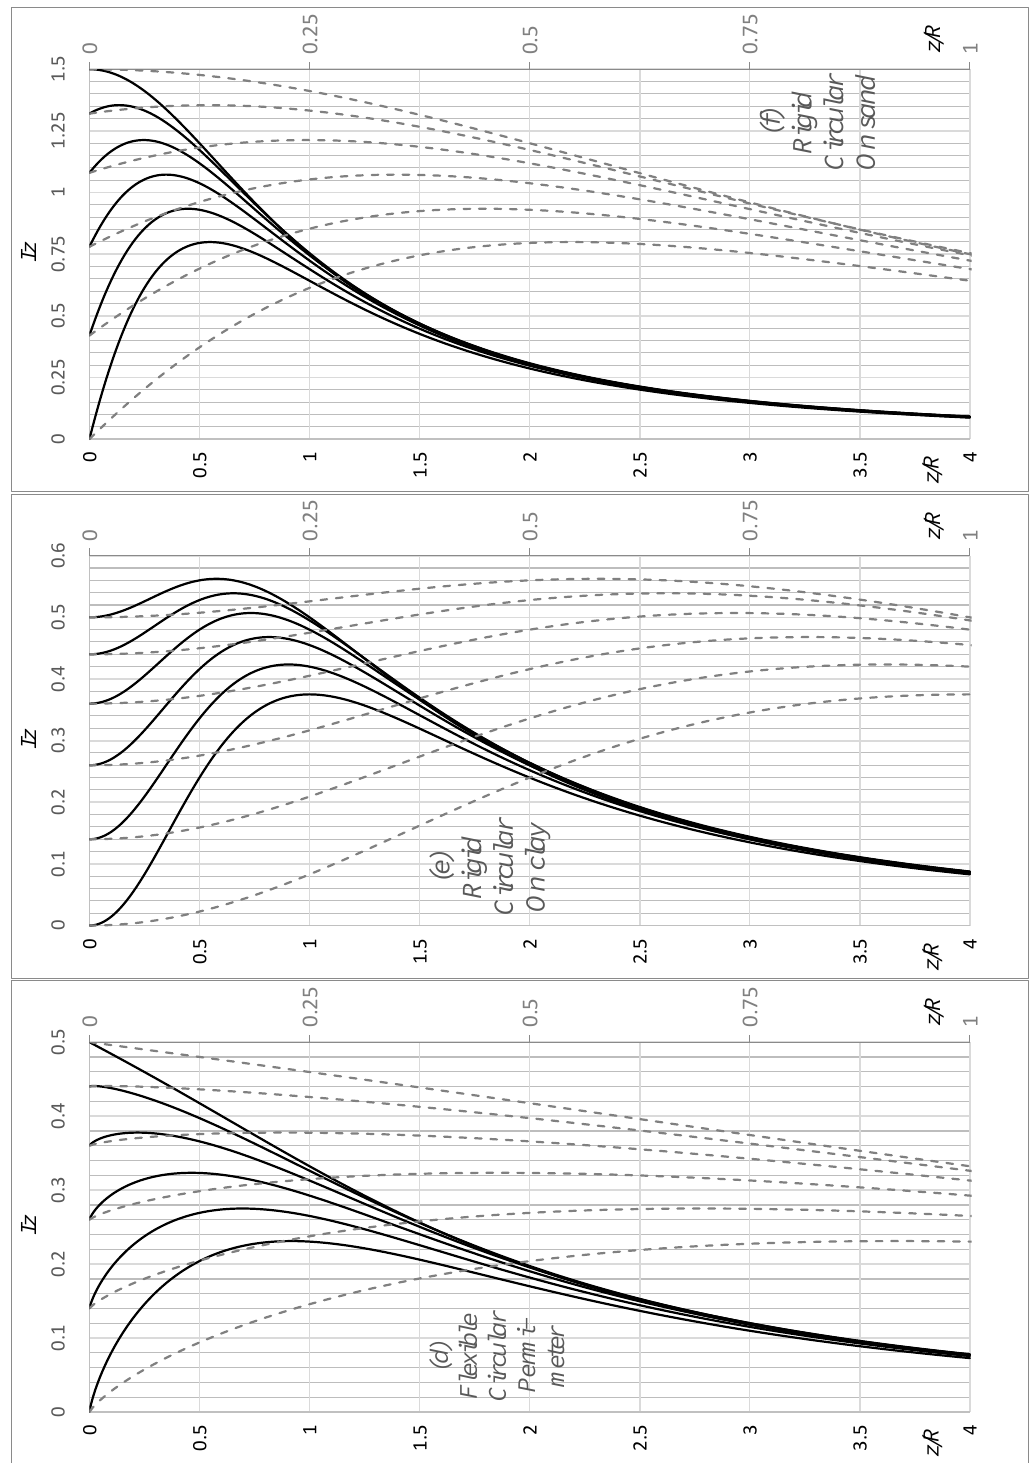
Figure 2. I z versus normalized depth charts for various ν values for circular footings; ν ranges from 0.5 to 0 (left to right) with 0.1 interval.